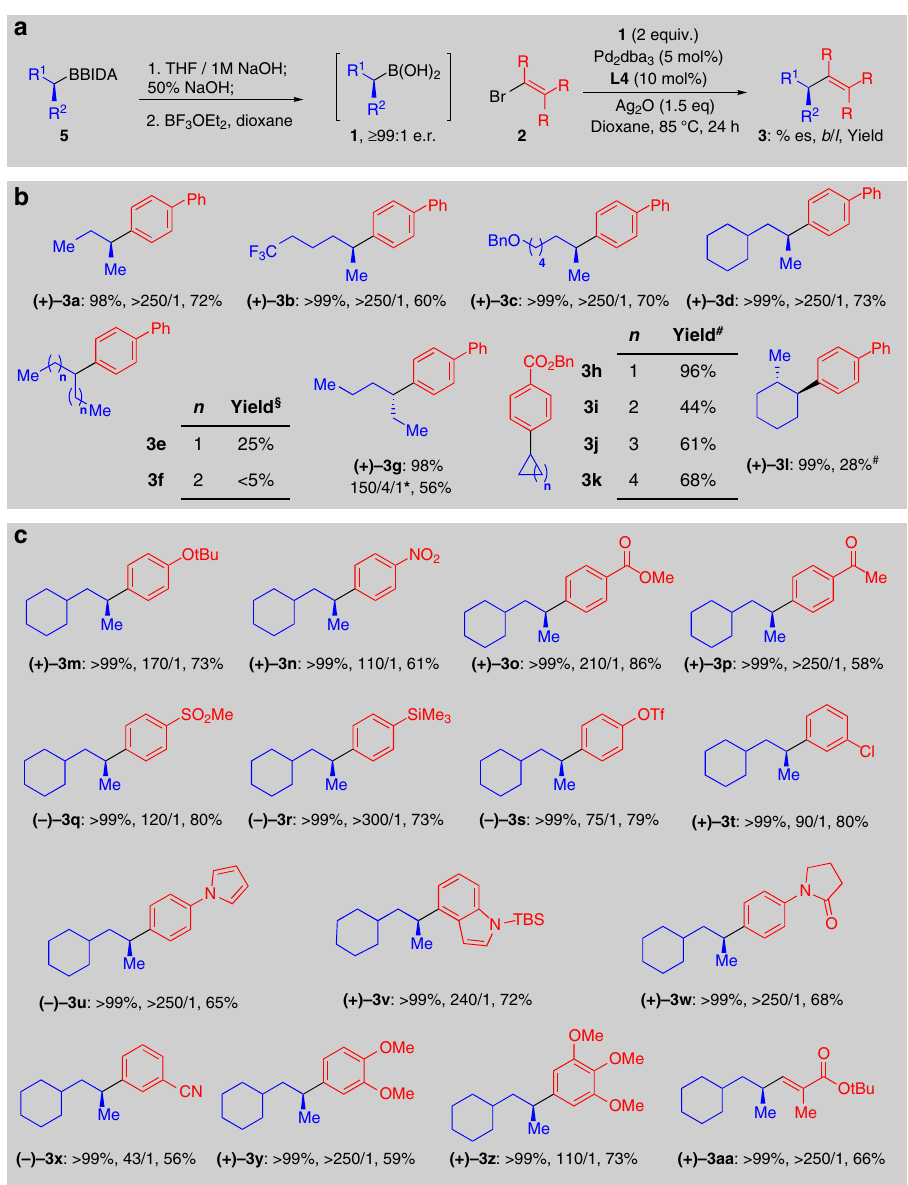
Fig. 4 Substrate scope of the sterospeci fi c cross-coupling reaction. a Reaction conditions. b Scope of the Csp 3 boronic acid coupling partner, ( § : no improvement when using L2 , * : branched on C3/branched on C2/linear (Supplementary Figure 5), # : L2 was used, L4 gave lower yields). c Scope of the bromide coupling partner. All reactions were performed in duplicate. Branched/linear ratios were determined by HPLC or GC analysis of the crude reaction using an authentic linear product standard. Yields were determined by isolation. Enantiospeci fi cities were determined by chiral HPLC of the puri fi ed